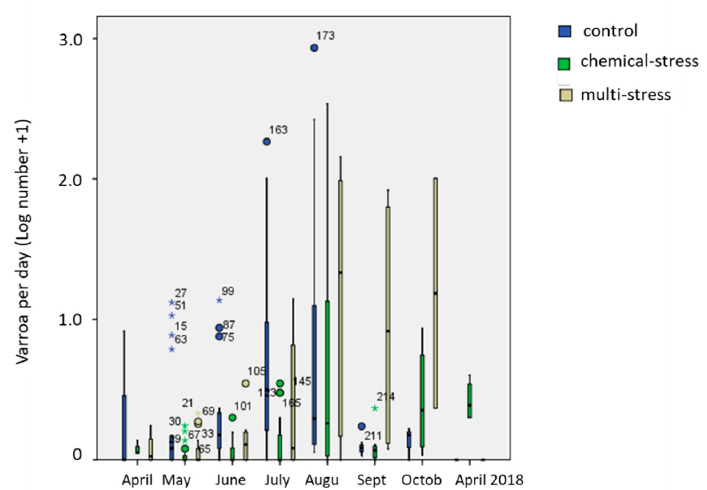
Figure 3. Box plot of fallen varroa mites per day (decimal logarithm of the mite number +1) in the experimental sites from April 2017 to April 2018. Circles indicate data faraway less than 3 times the interquartile distance; stars data faraway more than 3 times the interquartile distance.